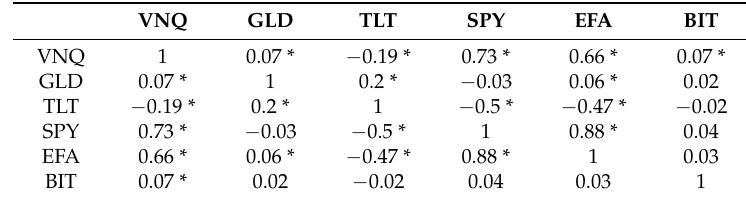
Figure 2. QQ plots of asset returns. Table 2. Correlation coefficients for daily percent returns.